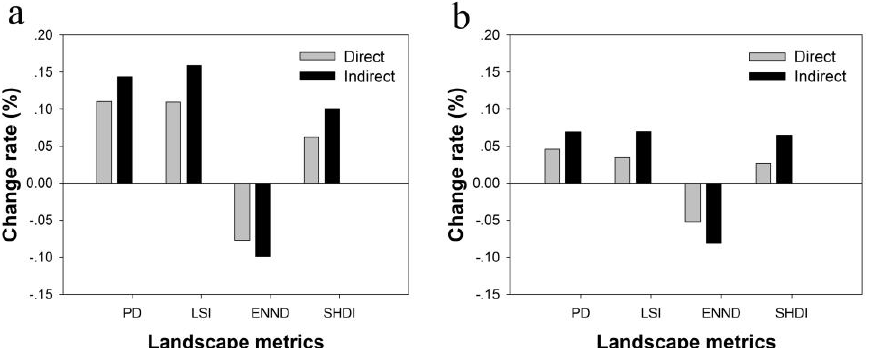
Figure 4. Changes of landscape metrics between direct and indirect impact of highway construction ( a ) changes of landscape metrics between 1990 and 2000; ( b ) changes of landscape metrics between 2000 and 2010.